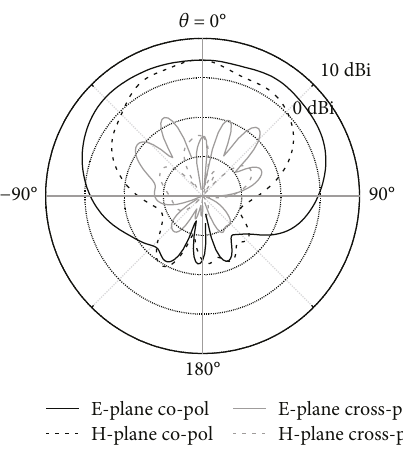
Figure 3: Simulated radiation patterns of the SIDRA element at 34.5